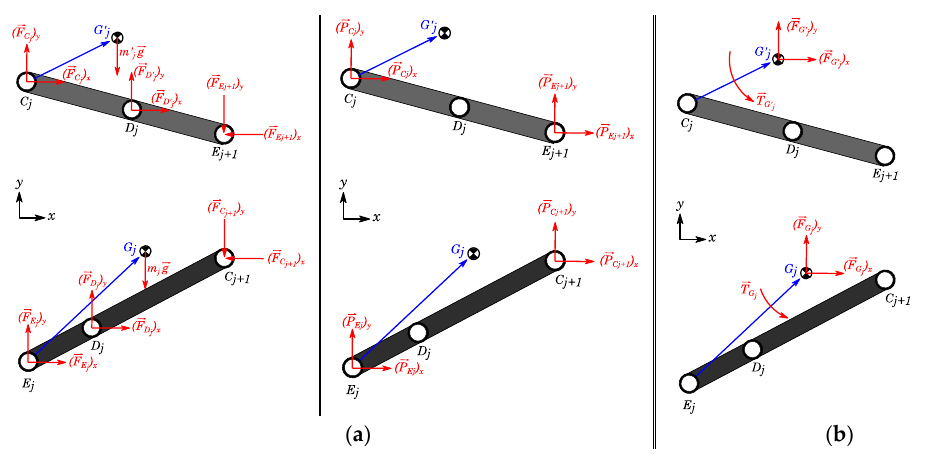
Figure 5. Free-body-diagram of an SLE: ( a ) internal-external forces, ( b ) effective forces.